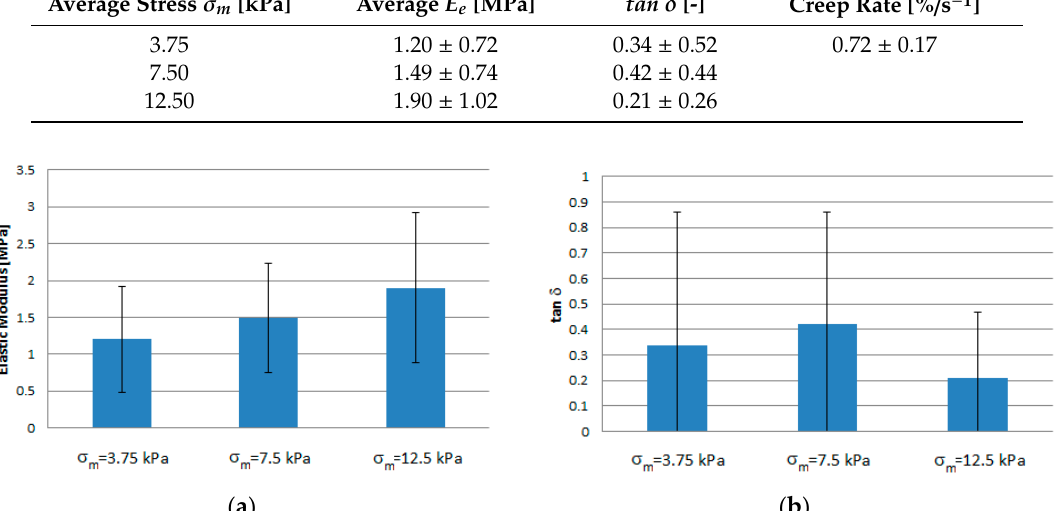
Figure 5. Elastic and viscous properties of ovarian tissue at different average stress σ m : ( a ) storage modulus ( E e ); ( b ) loss tangent ( tan δ ). Table 1. Mechanical properties of cortical ovarian tissue.